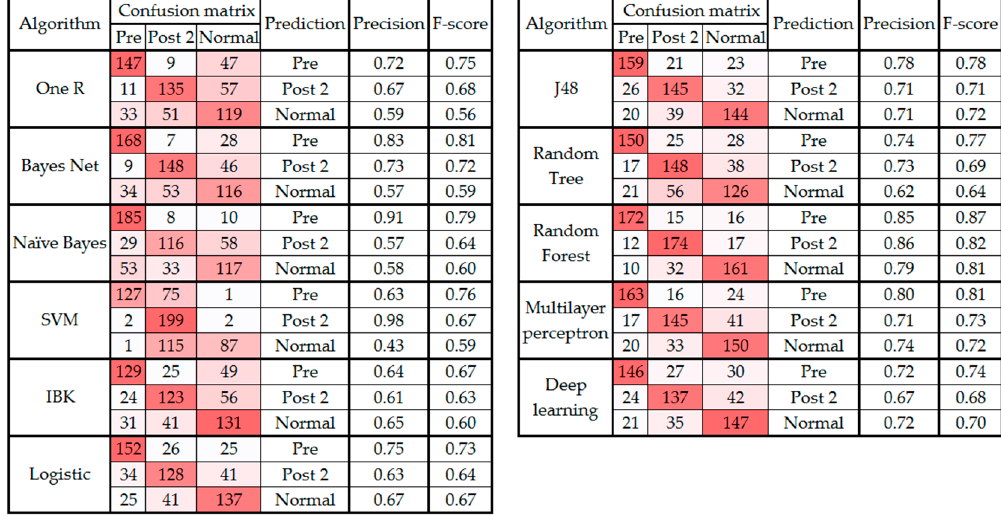
Figure 3. Confusion matrix, precision, and F ‐ score from classification algorithms classifying data into three classes before feature selection.